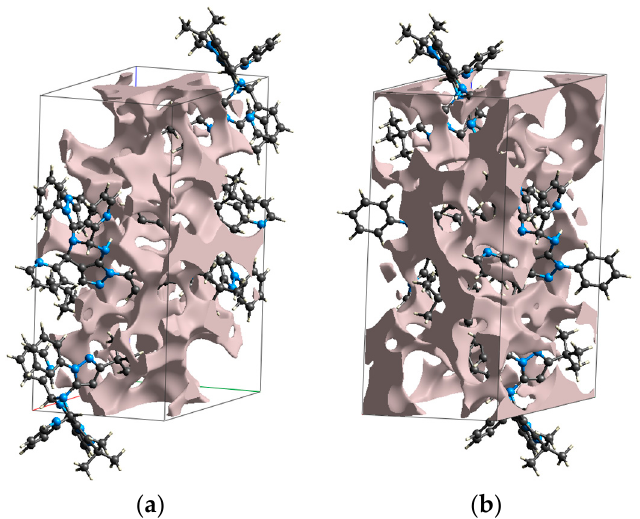
Figure 12. Void surfaces (isovalue 0.002 eau − 3 ) within the unit cells of crystalline polymorphs 9a ( a ) and 9b ( b ).